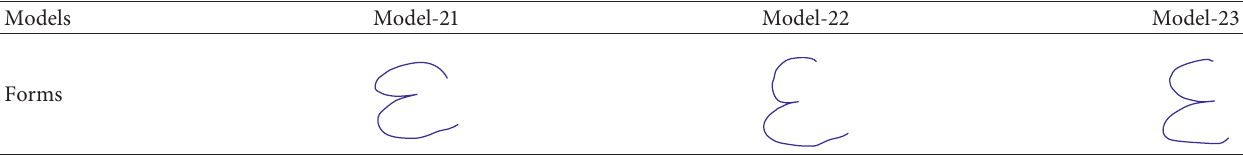
Table 3: Examples of the Arabic letter “AYN,” written by writer-2.